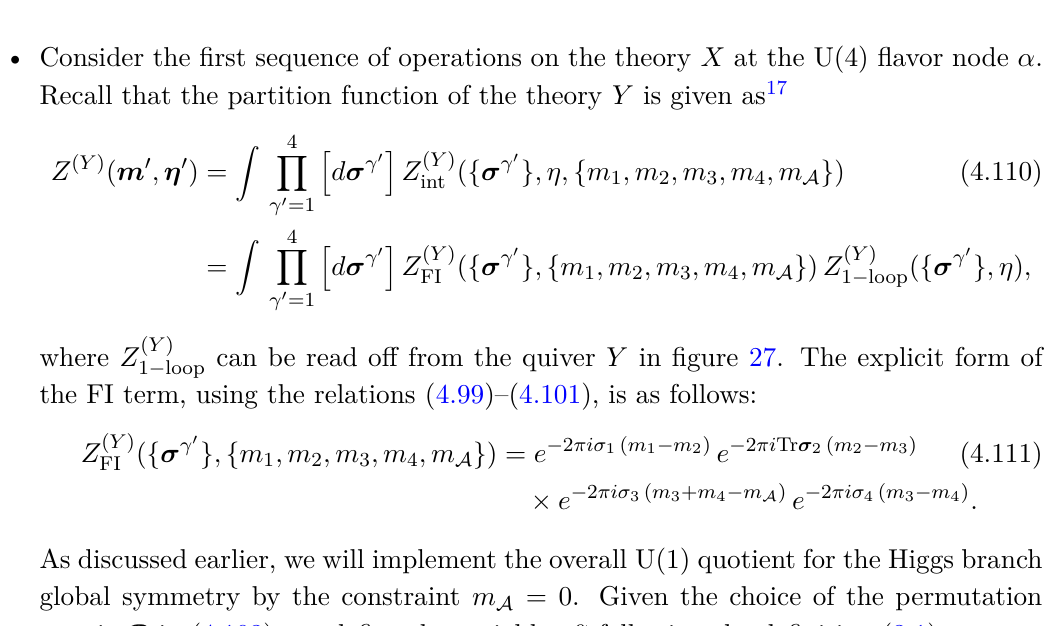
Figure 28 . The mirror dual pair ( X, Y ) in figure 27 can be derived from a pair of linear quivers shown in the top line by an Abelian gauging operation. The details of the computation can be found in section